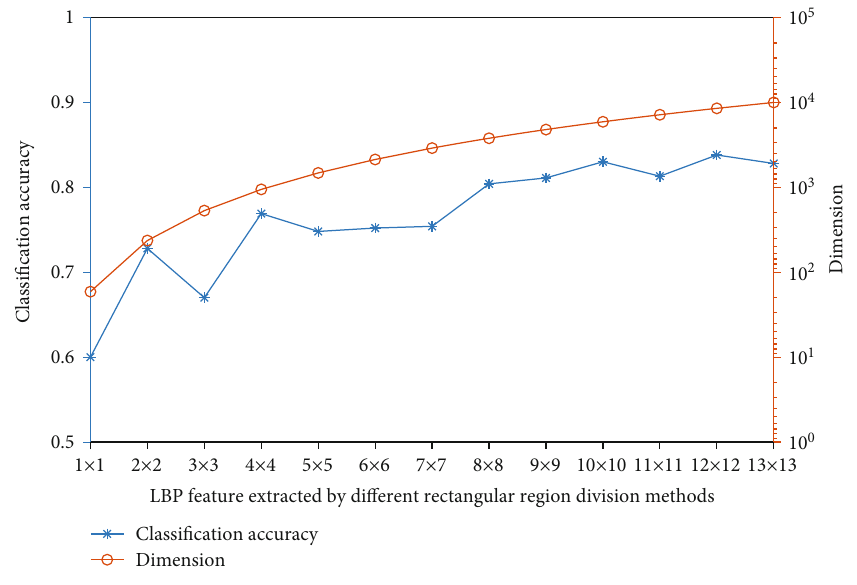
Figure 18: Classi fi cation accuracy corresponding to di ff erent LBP features.